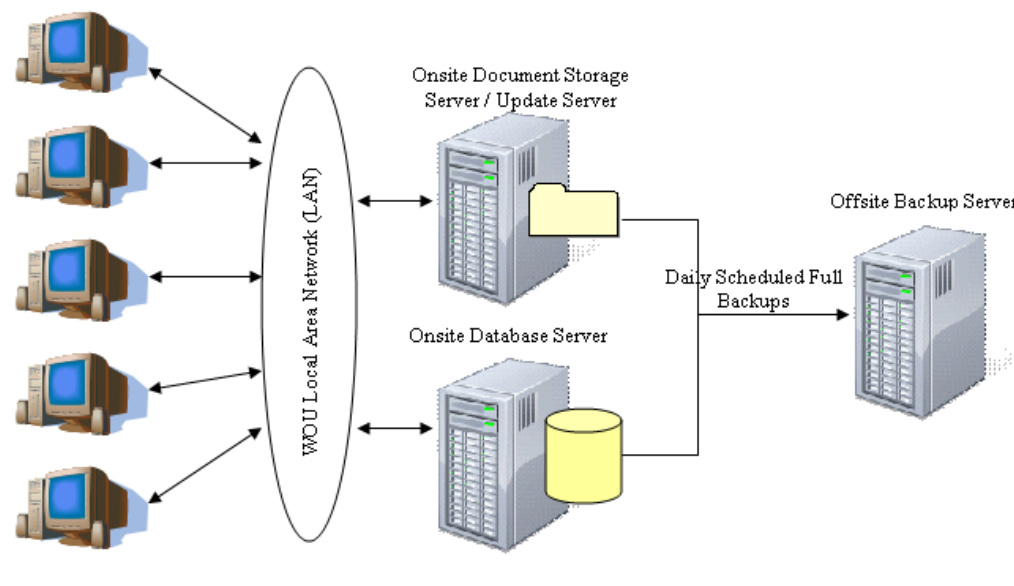
Figure 3 : CDTS system